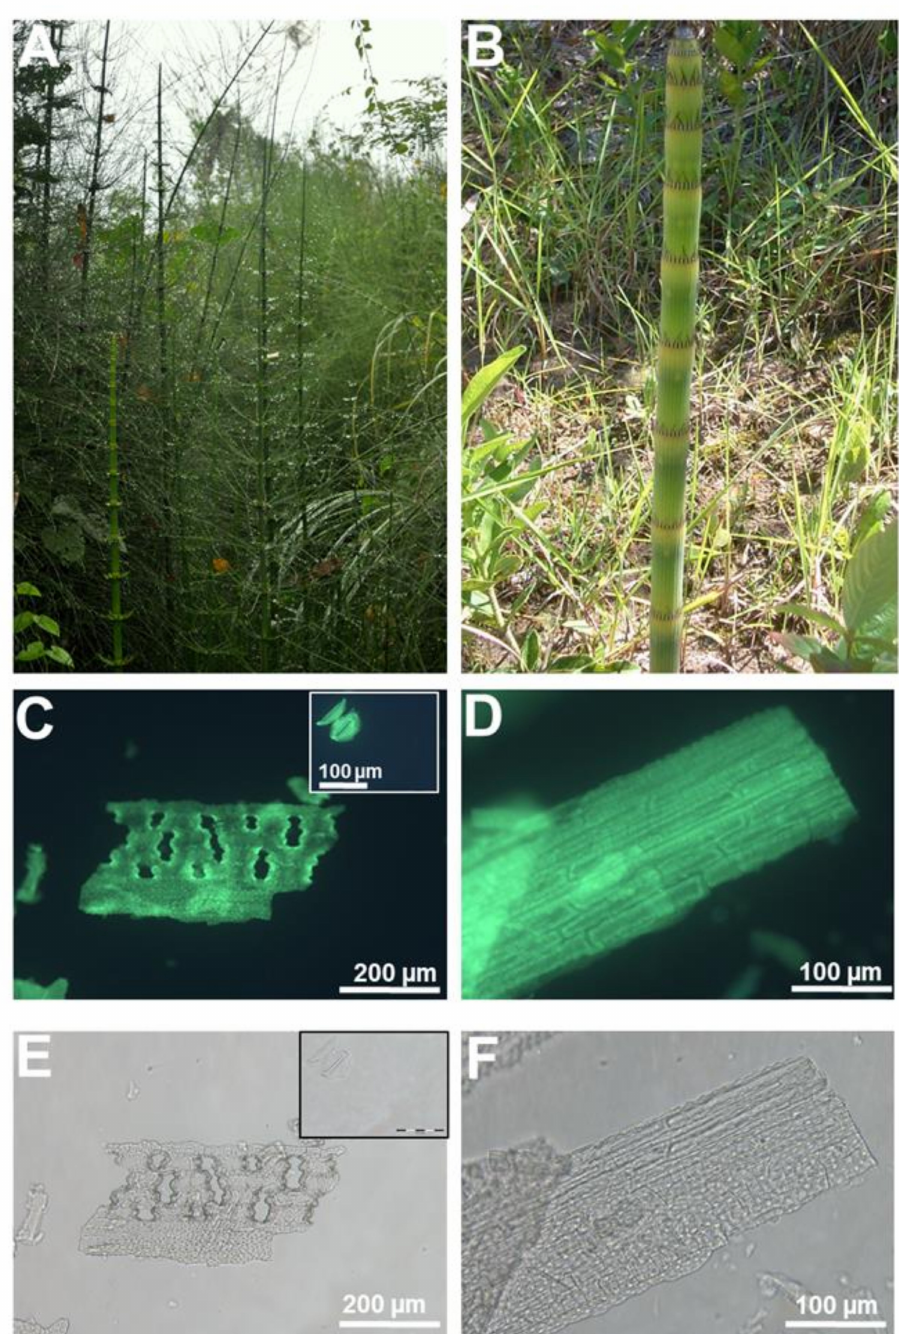
Figure 1. Heavily silicified giant horsetail ( Equisetum myriochaetum L.). ( A , B ) Giant horsetail growing in the wild (Peruvian Amazon). ( C ) Biogenic silica in giant horsetail’s stem following acid extraction and fluorescence imaging with 2-(4-pyridyl)-5-((4-(2-dimethylaminoethylaminocarbamoyl)methoxy) phenyl)oxazole (PDMPO). Holes corresponding to sunken stomata are visible. Inset: heavily silicified stomata with fine details of radiating ribs in the guard cells. ( D ) Undulating silicified cell walls of the epidermal cells on the stem. ( E , F ) Di ff erential interference contrast images of ( C ) and ( D ). Images were taken using an Olympus BX50 fluorescence microscope (Southend-on-Sea,